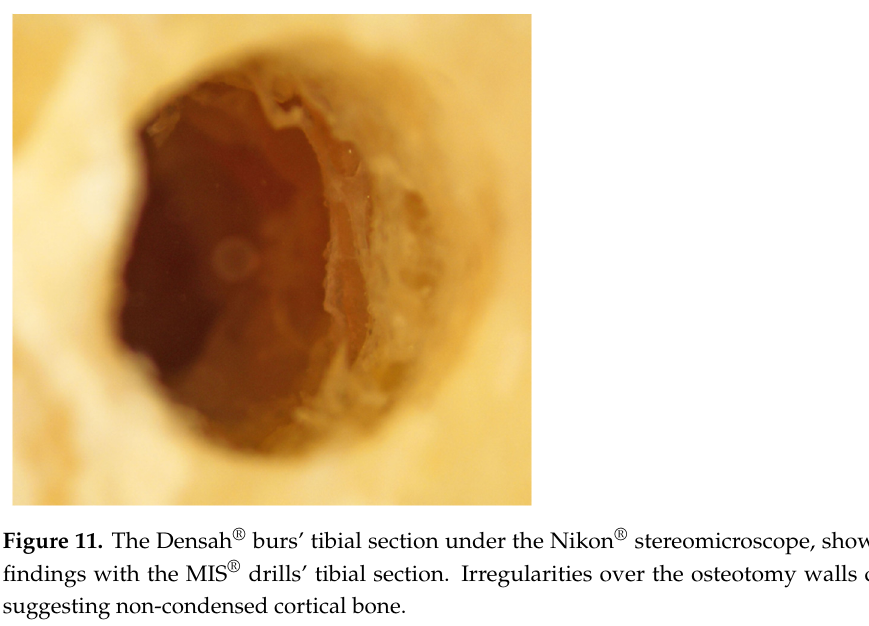
Figure 10. The MIS ® drills’ tibial section under the Nikon ® stereomicroscope. Irregularities can be seen over the osteotomy walls, suggesting non-condensed cortical bone.